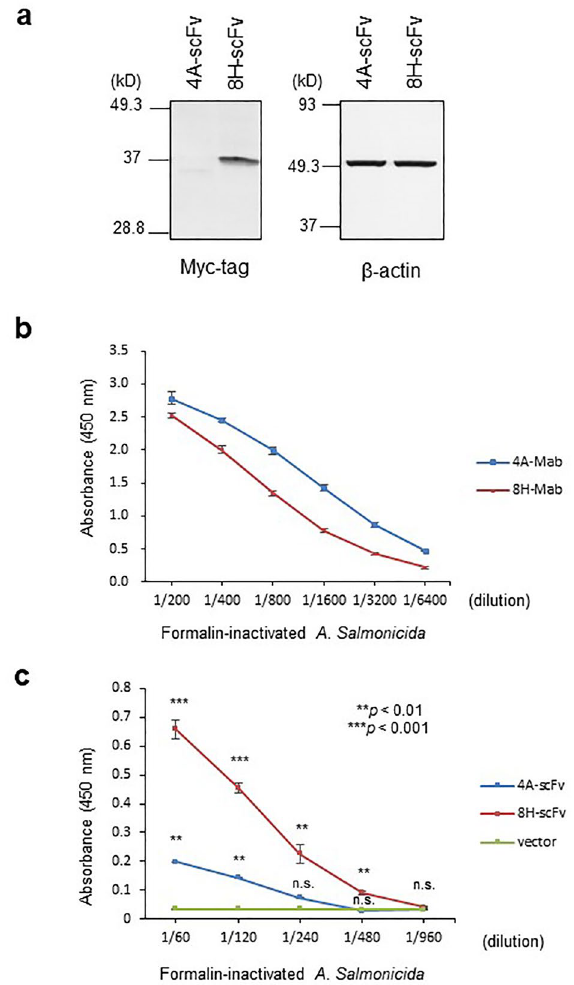
Figure 1. Anti- As scFvs expression in DO-11.10 cells and As binding assay. ( a ) Western blotting of anti- As 4A and 8H scFvs in transfected DO-11.10 T-cells. The immunoblots were probed with an anti-Myc-tag polyclonal antibody or anti-β-actin MAb. Full-length gels/blots are indicated in Supplementary Figure S2. ( b ) Binding assay of parental anti- As MAbs (4A and 8H) by ELISA. (c) Binding assay of anti- As scFvs by ELISA. DO-11.10 T-cell lysates transfected with DNA encoding anti- As 4A and 8H scFvs were used. The indicated dilutions of formalin- inactivated A. salmonicida were added to each well. Values are shown as mean ± standard error of duplicate reactions and are representative of three independent experiments. Asterisks represent a significant difference between the control (vector) and scFv (** p < 0.01; *** p <